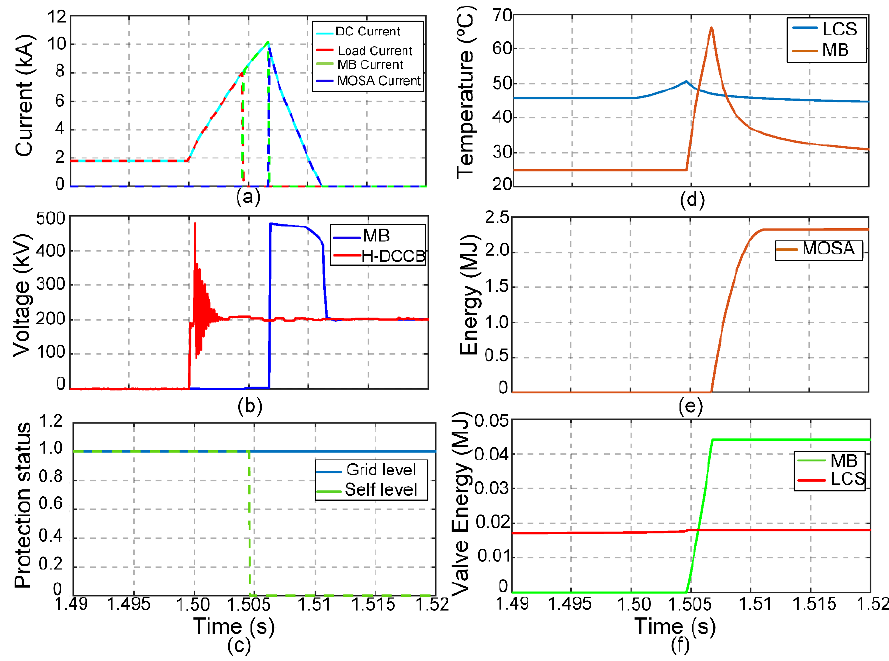
Figure 9f. This is because only a small number of IGBT valves are used in LCS as well as turning-on of the MB valves at the time of commutation of current only.